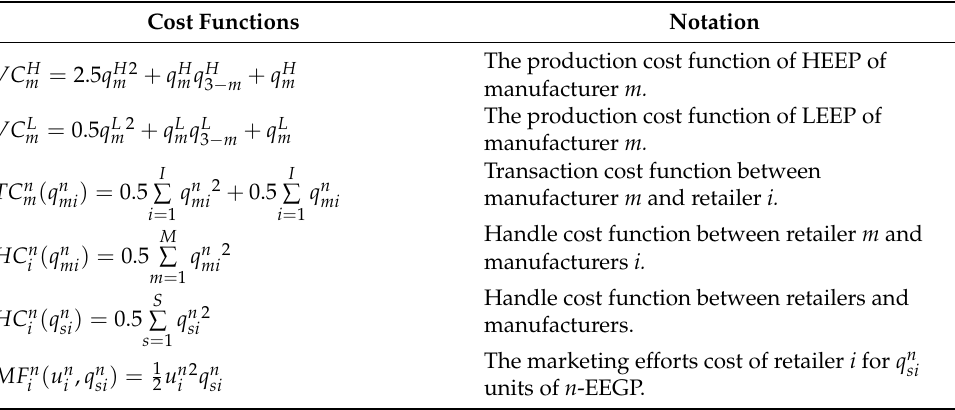
Table 2. Description of cost functions involved in numerical example. Cost Functions